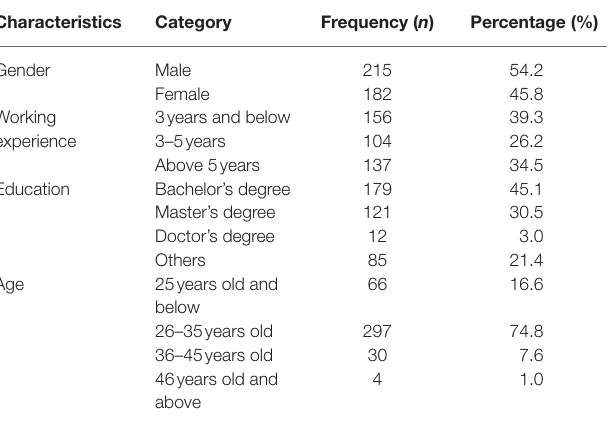
TABLE 1 | The detailed socio-demographic characteristics of respondents. ( N =